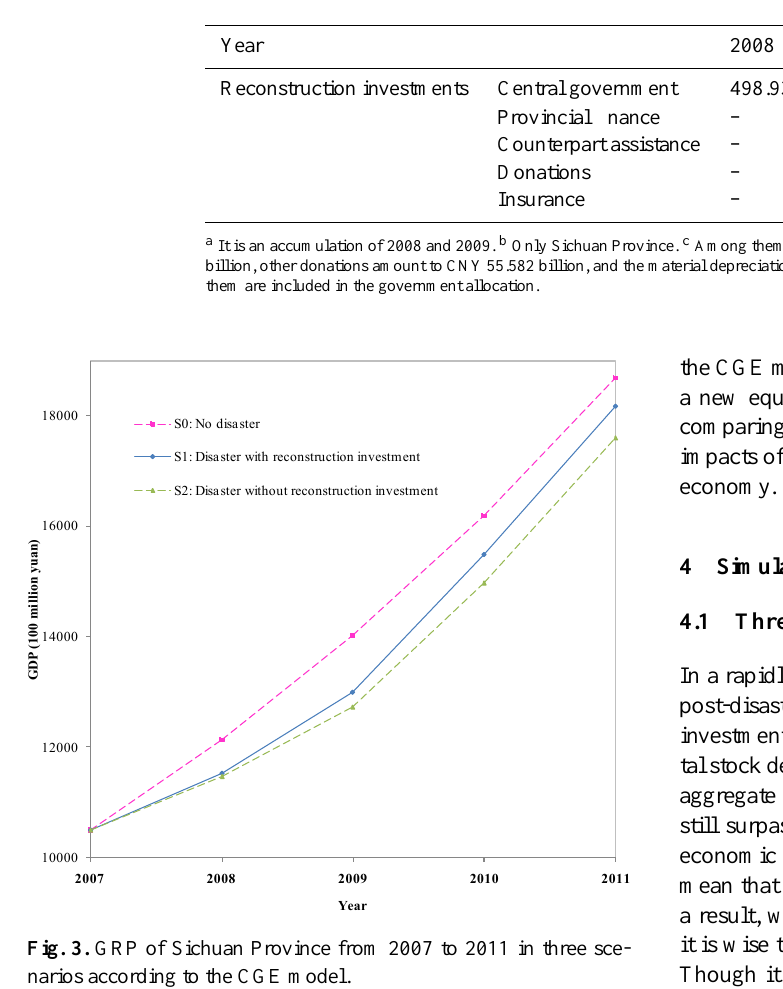
Table 2. Reconstruction investments supported by government over the 3yr after the earthquake (unit CNY100 million).